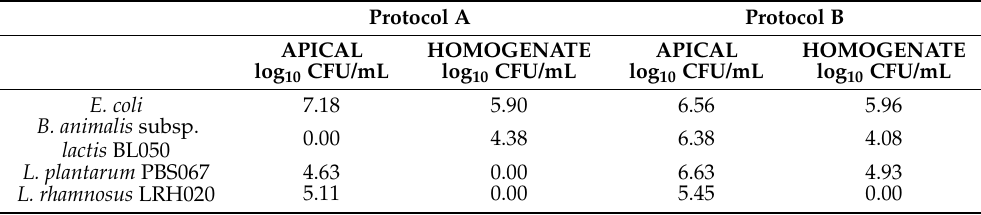
Table 3. Antimicrobial and preventive-antiadhesive efficacy of B. animalis subsp. lactis BL050, L. plantarum PBS067 and L. rhamnosus LRH020 vs. E. coli ATCC 8739 on HBE. The amount of each strain and the pathogen was expressed as log 10